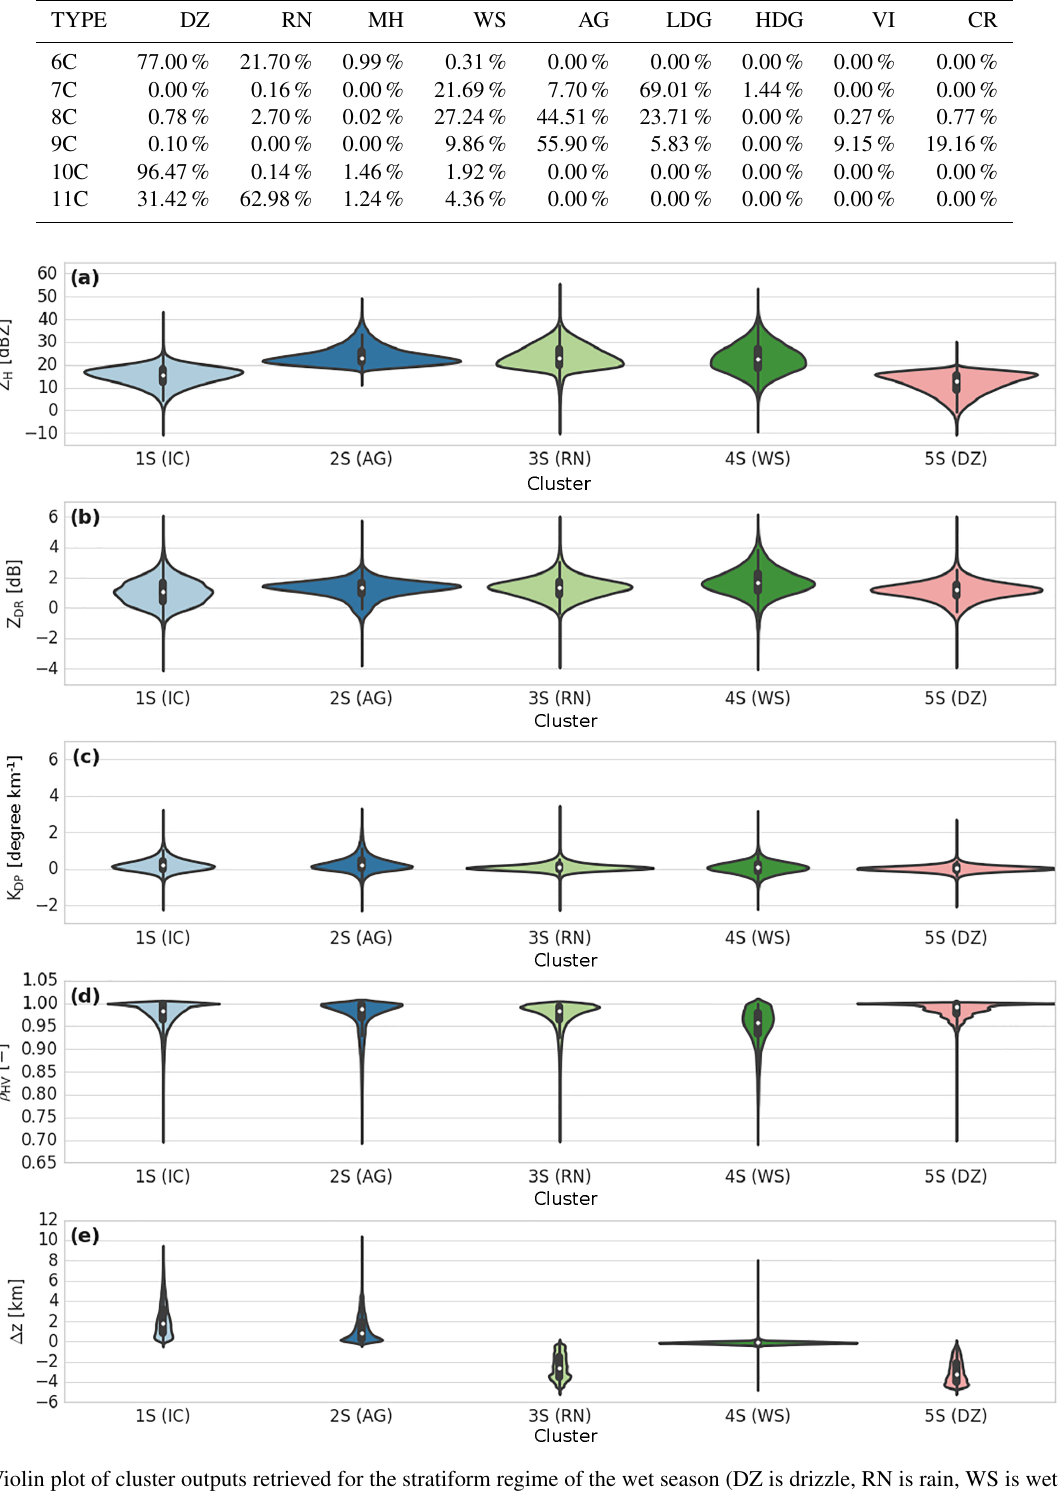
Table 4. Same as Table 3, but for the convective region of the wet season.